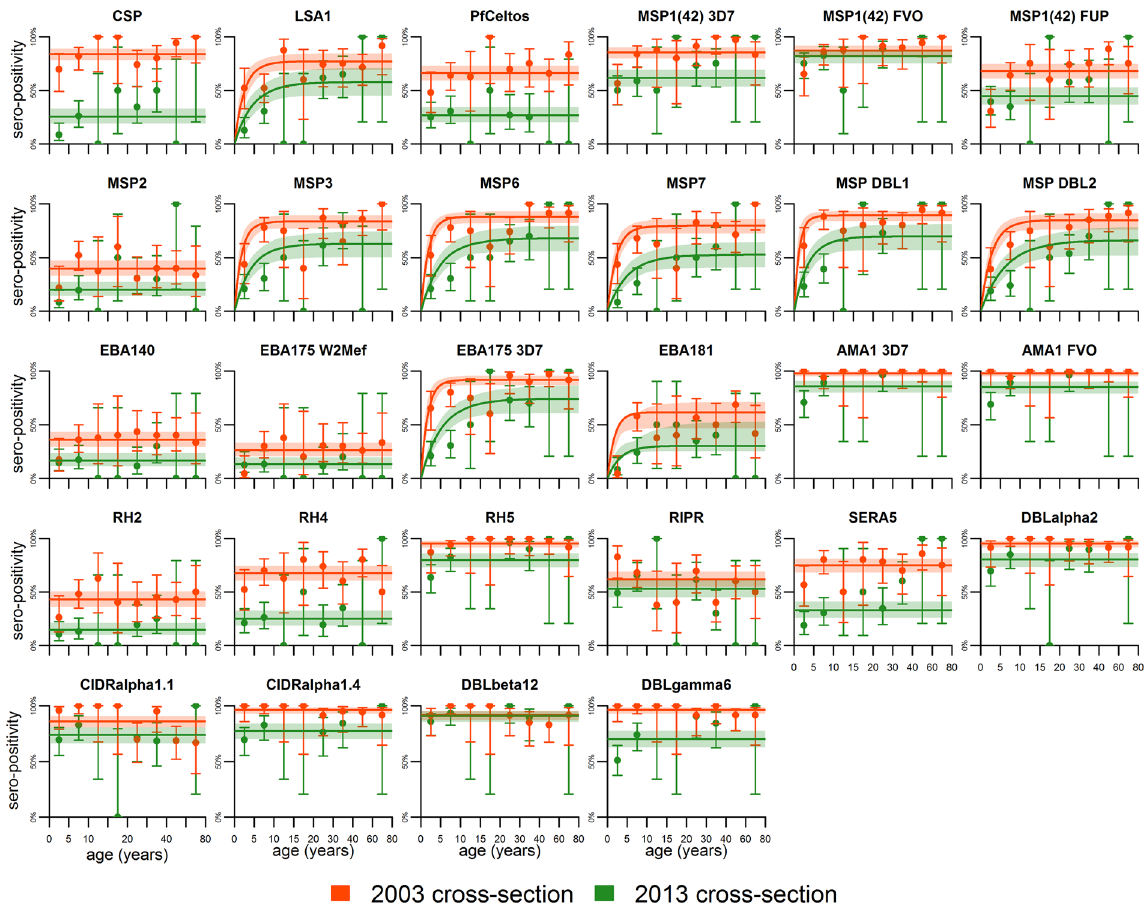
Figure 2. Age-related sero-positivity to 28 Plasmodium falciparum antigens in 2003 and 2013 cohorts. A multiplexed antibody assay was performed using recombinant antigens conjugated to microsphere beads as described previously 45 . Mean fluorescent intensity (MFI) values obtained from the assay were divided by the average MFI of malaria naïve North American controls. MFI values greater than the mean MFI + 3 standard deviations of malaria naïve controls were considered sero-positive. The data are presented as the sero-positive proportion with 95% confidence intervals in different age bins. Continuous lines represent the best model fit. The shaded areas denote the 95% credible interval of the model